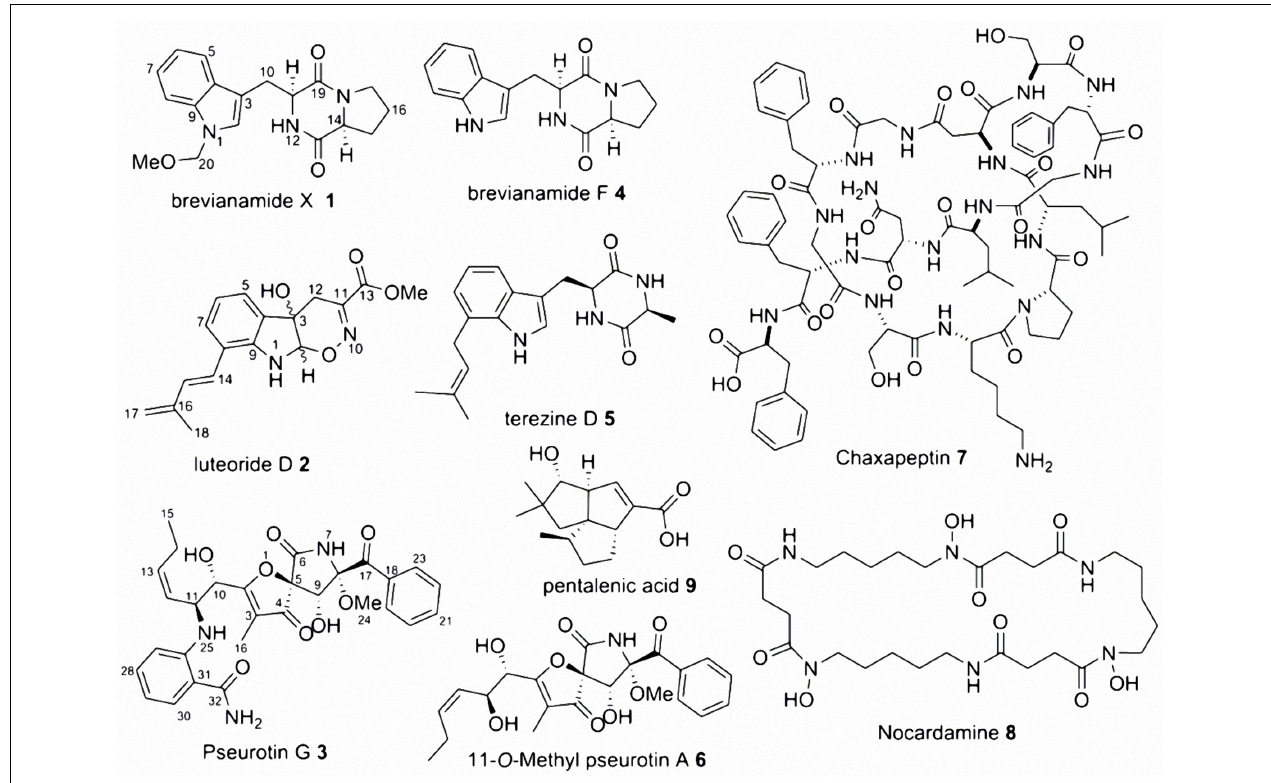
FIGURE 1 | Compounds isolated from the microbial co-culture of Aspergillus fumigatus MR2012 and Streptomyces leeuwenhoekii strains C34 and C58 in addition to that isolated from the axenic marine-derived A. fumigatus MR2012.